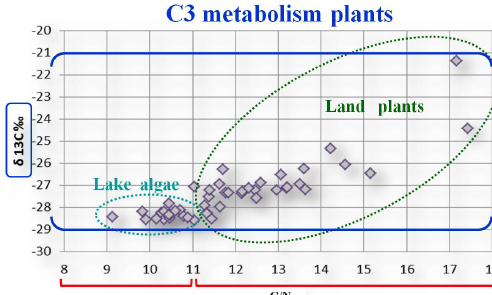
Figure 6. δ 13 C and C / N bi-plot (from Meyers, 1994).